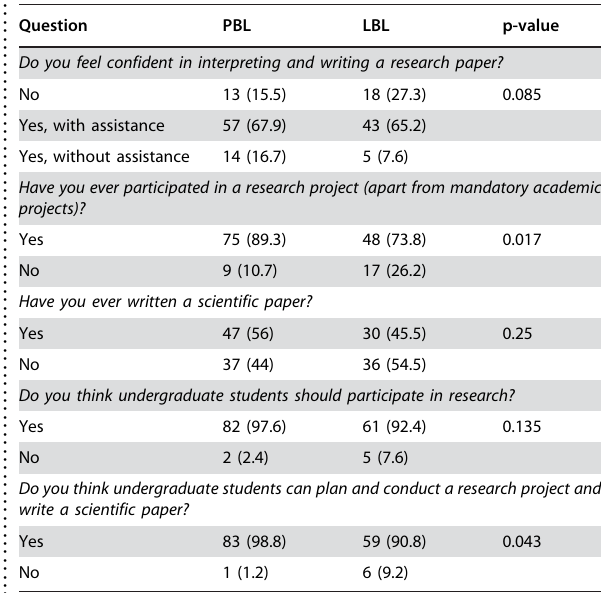
Table 2. Comparison of responses to questions